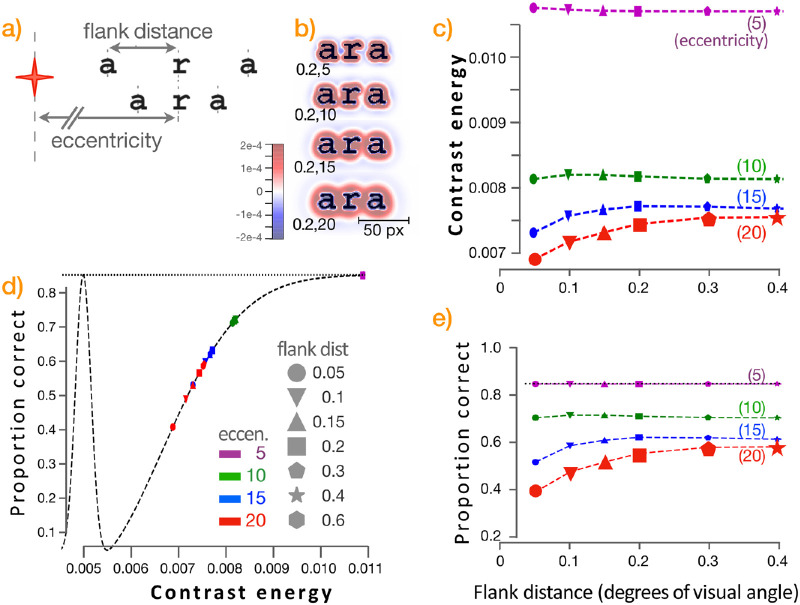
(a) Target objects (letters large and small; the letter “r” for this example) at different eccentricities from a fixation point (red) are surrounded with non-target objects at different flanking distances. (b) Heat maps show several sample images with the same flank differences but different eccentricities, convolved with the corresponding difference-of-Gaussians Jacobian (Equation 3). The lower the eccentricity, the less radial contamination from neighboring pixels in the convolved image. (c) Generalized contrast energy (Equation 4) is computed from flank distance (0.05 to 0.4 degree of visual angle) at several different eccentricities (5–20 degrees of visual angle). Even in the presence of flanking objects, contrast is relatively stable until those flankers encroach on the target (closer than ∼0.15° from the target). Less flanker-induced contrast reduction occurs at eccentricities closer to the fovea. (d) From the flanker-dependent and eccentricity-dependent contrast values, the mapping function (Equation 5) calculates estimated proportion of correctly identified targets. At lower contrast energy values, the effect of different contrasts on correct identification is steeper; that is, slight changes to contrast energy can substantially change estimated target identification rates. At higher contrast energy values, the effect saturates. (e) Combining (c) and (d), the predicted ability to identify a target is shown as a function of flank distance and eccentricity.